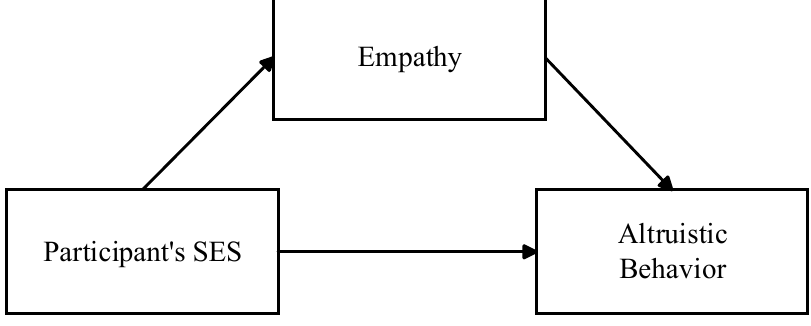
Figure 1. Hypothesized model.